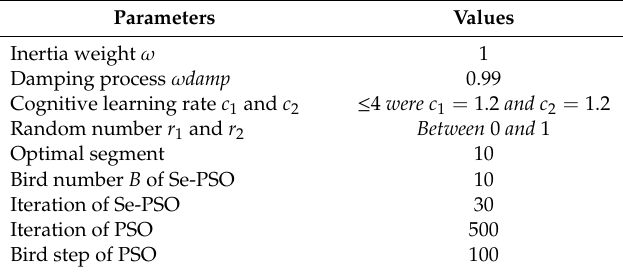
Table A5. The parameters used in the